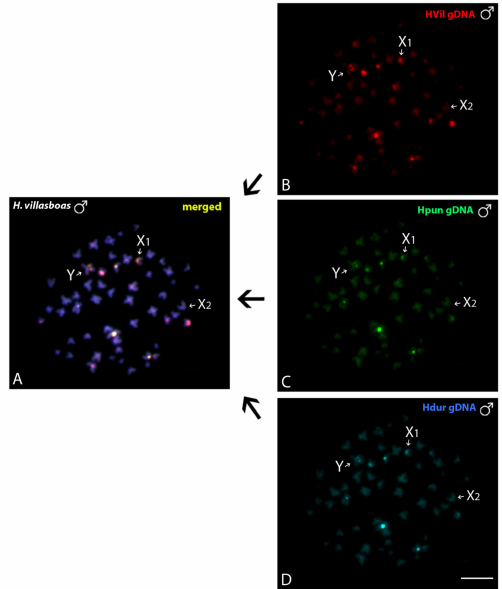
Figure 6. Comparative Genomic Hybridization (CGH) of Harttia species bearing X 1 X 2 Y sex chromosome system. Mitotic male chromosome spreads of H. villasboas ( A ) hybridized against male-derived genome probes of H. villasboas ( B ), H. punctata ( C ) and H. duriventris ( D ). Sex chromosomes are indicated and the common genomic regions for the three species are depicted in yellow on ( A ). Bar = 10 µ